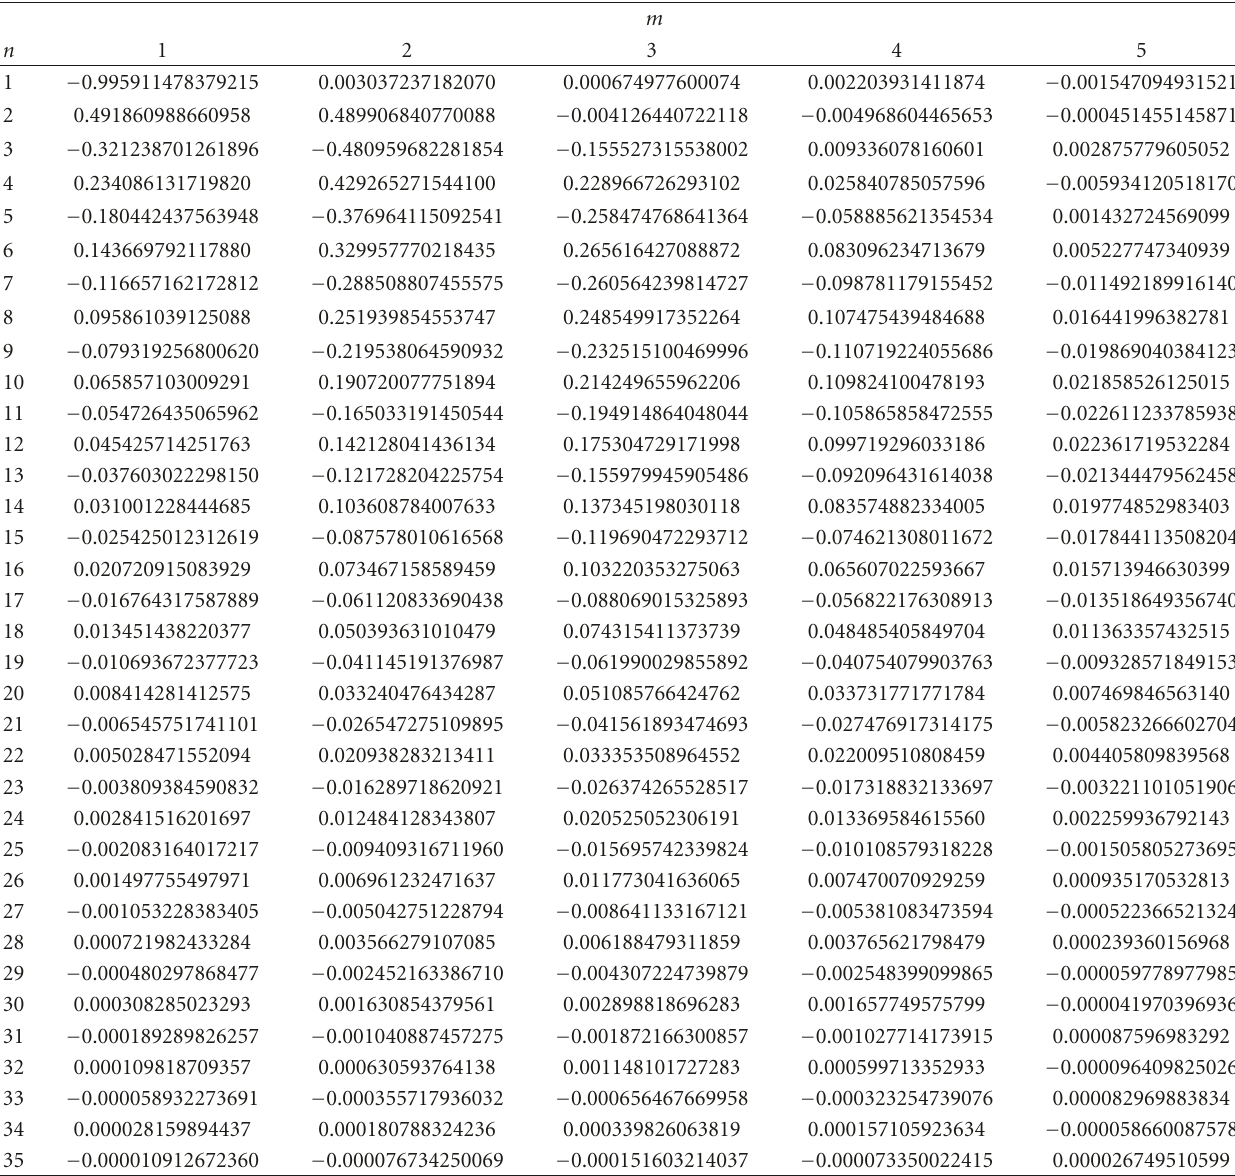
Table 2: Filter coe ffi cients for the proposed LS design in Example